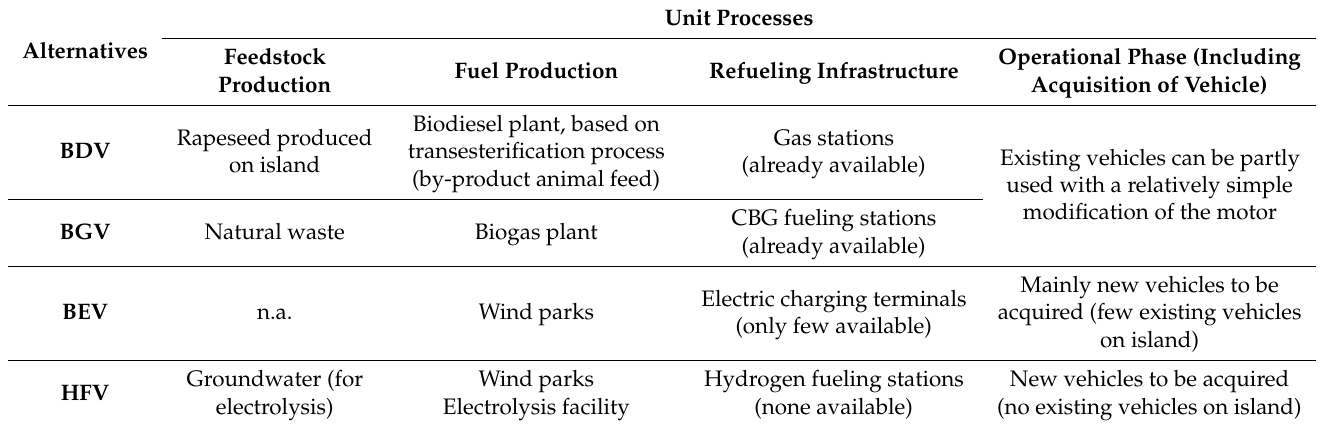
Table 2. Crucial factors for each unit process and alternative.